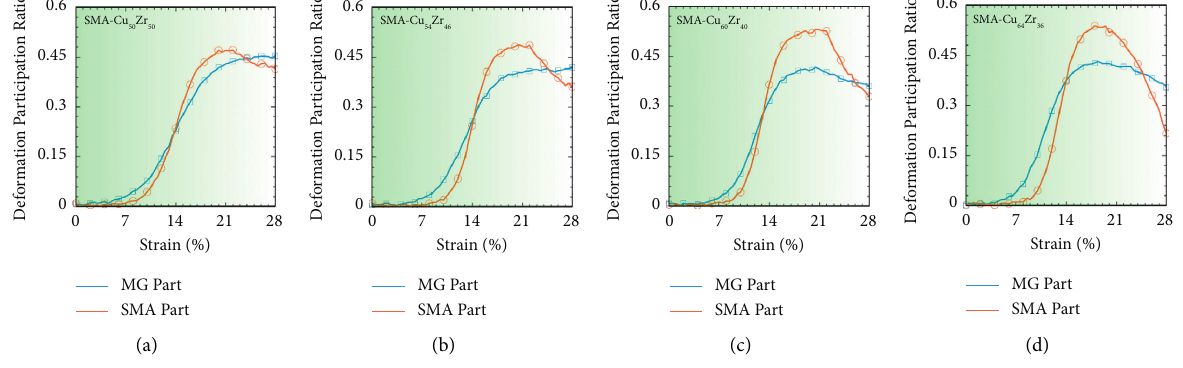
Figure 3: The deformation participation ratio based on η